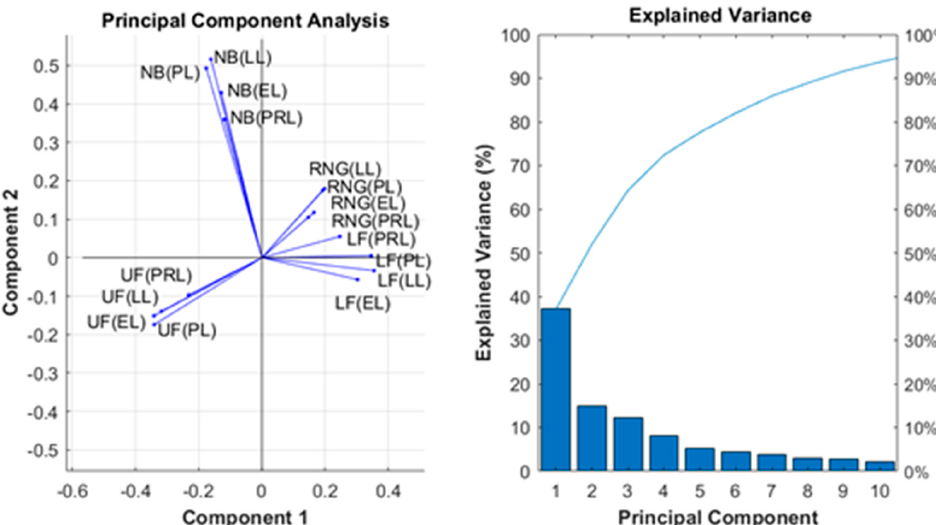
Figure 2. ( Left ) Principal Component Analysis (PCA) across all 16 features visualized using a biplot normalized to arbitrary units. UF, LF, RNG, and NB notation refers to the mean durations spent at the upper feeder, lower feeder, range, and nest box, respectively, for each of the denoted productions periods (pre-lay = PRL, peak lay = PL, late lay = LL, and end of lay = EL). ( Right ) A Pareto chart plotting the proportion of explained variance within each component. The blue line plots the cumulative variance across the components from left to